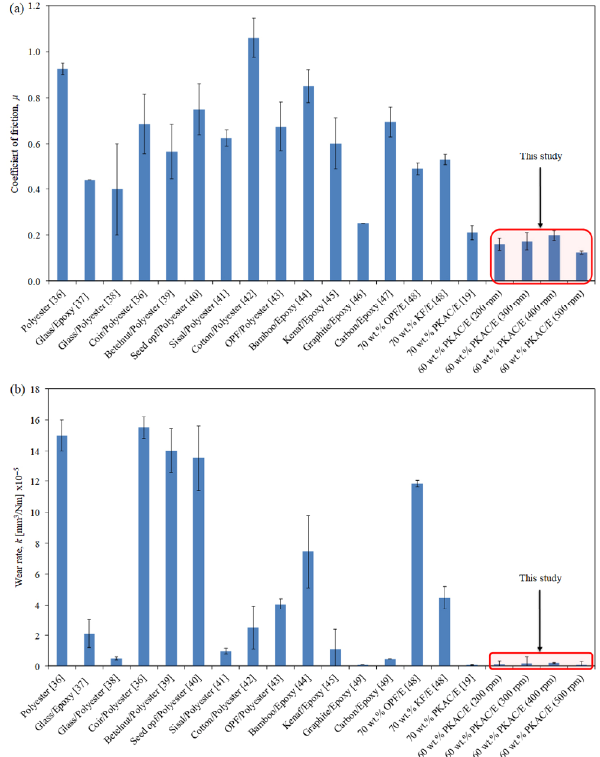
Fig. 7 (a) Coefficient of friction and (b) specific wear rate of synthetic and other agricultural waste-based polymeric composite under dry sliding conditions and tested at room temperature. The error bar is for the standard deviation. (Note: PKAC/E is an acronym for activated carbon-epoxy composite derived from palm